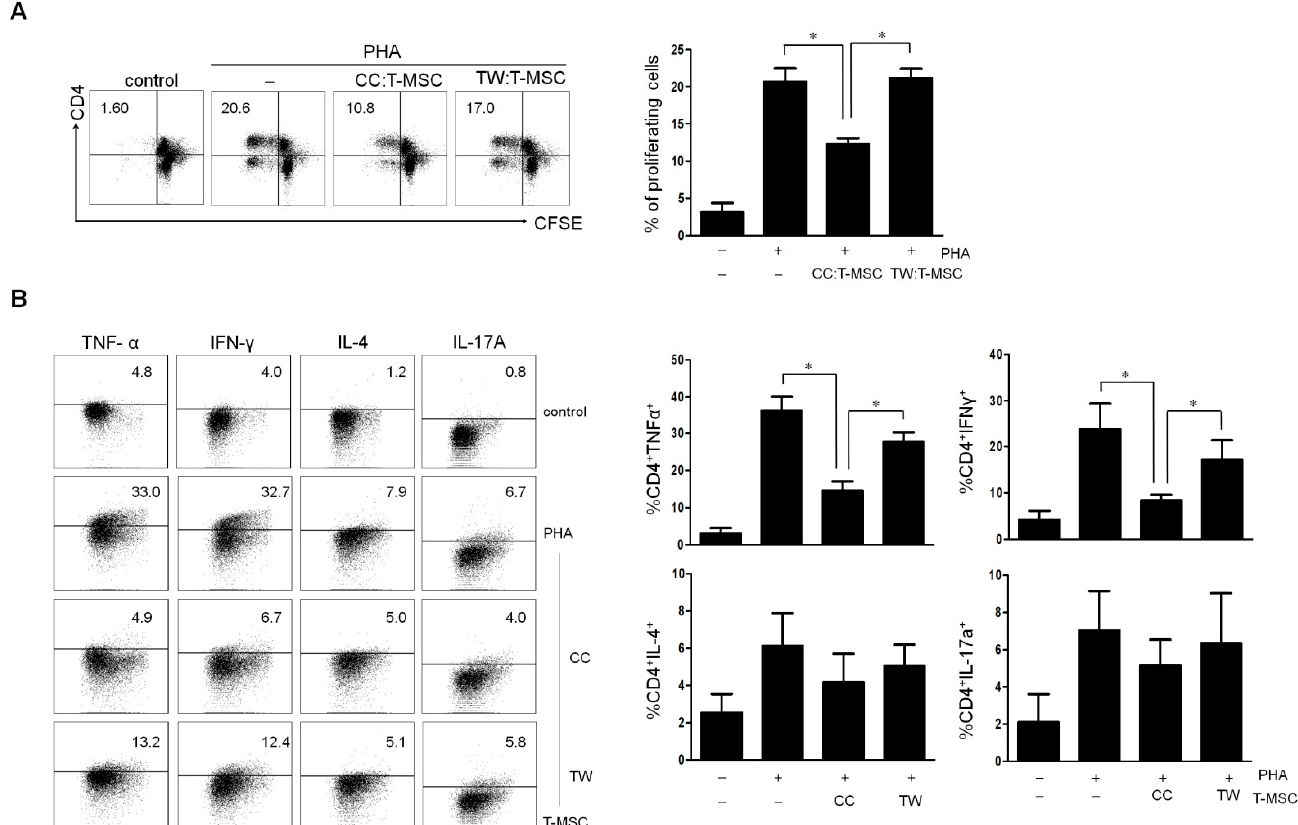
Figure 2. Assessment of tonsil-derived mesenchymal stem cells (T-MSCs)-mediated immunosuppressive function. ( A ) Flow cytometric analysis of the proliferating immune cells after direct or indirect co-cultured with T-MSCs for 4 days. ( B ) Flow cytometric analysis of TNF- α , IFN- γ , IL-17A, and IL-4 expression in CD4 + T cells after direct or indirect co-cultured with T-MSCs for 4 days. Dot blots are representative of each independent experiment and the graphic data is the ± SEM from three independent experiments (* p < 0.05). T-MSC: tonsil-derived mesenchymal stem cell; PHA, phytohemagglutinin; CC, cell–cell contact; TW, transwell.